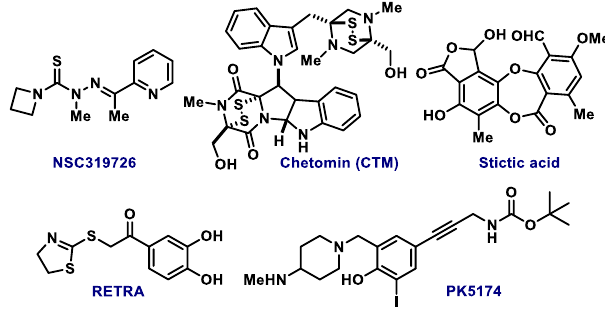
Figure 3. Structure of p53 reactivators with varying features.